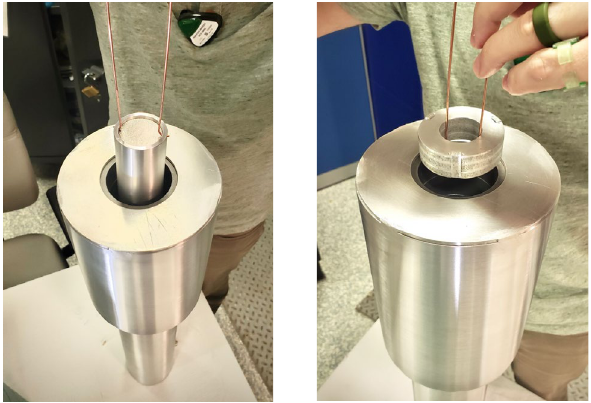
Fig.4. Collimator components for the RSEC – NIF beam port: insertion of the Bi-gamma-filter (left) and the boral aperture (right) in the corresponding section of the beam port.